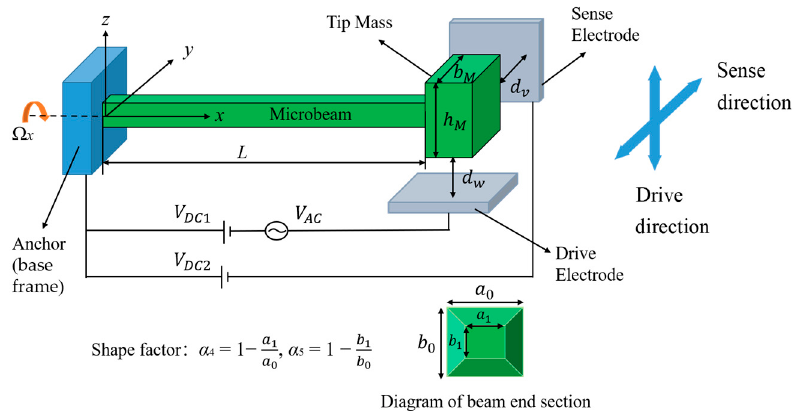
Figure 1. Schematic diagram of the tapered beam micro-gyroscope.